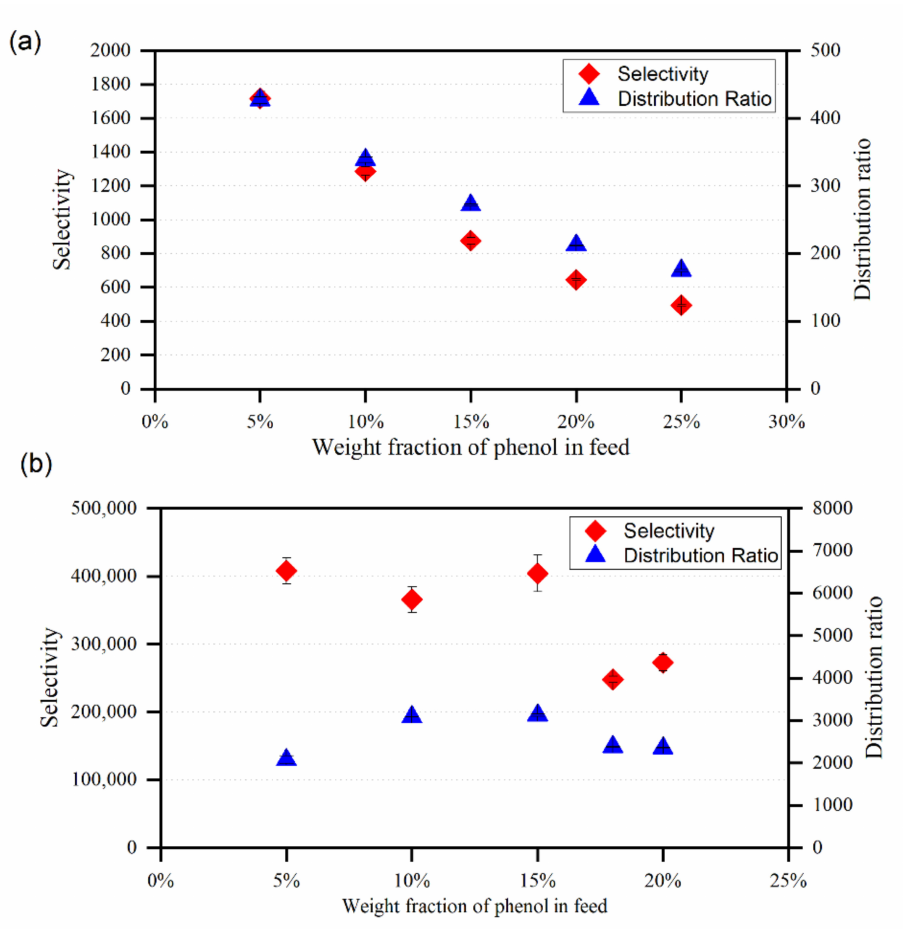
Figure 10. Variation of the selectivity and distribution ratio with phenol mole fraction in the feed for ( a ) {toluene + phenol + MTPPBr/EG (1:3)}, ( b ) {heptane + phenol + MTPPBr/EG